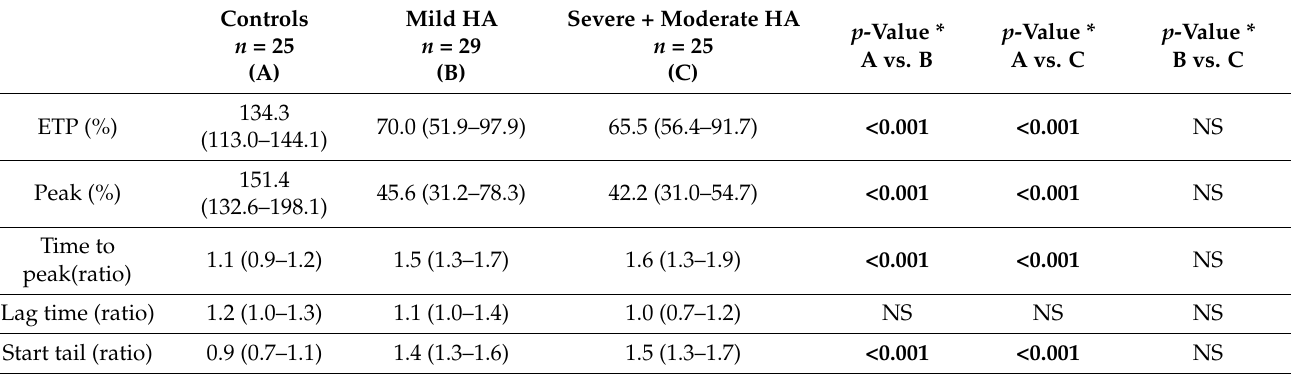
Table 3. Thrombin generation parameters in the HA patient cohort and healthy